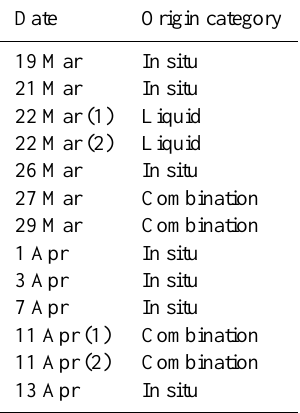
Table 1. ML-CIRRUS flight dates and respective origin categoriza- tion. Classification as “combination” means that both in situ and liquid origin cirrus were observed. Some days contain more than one